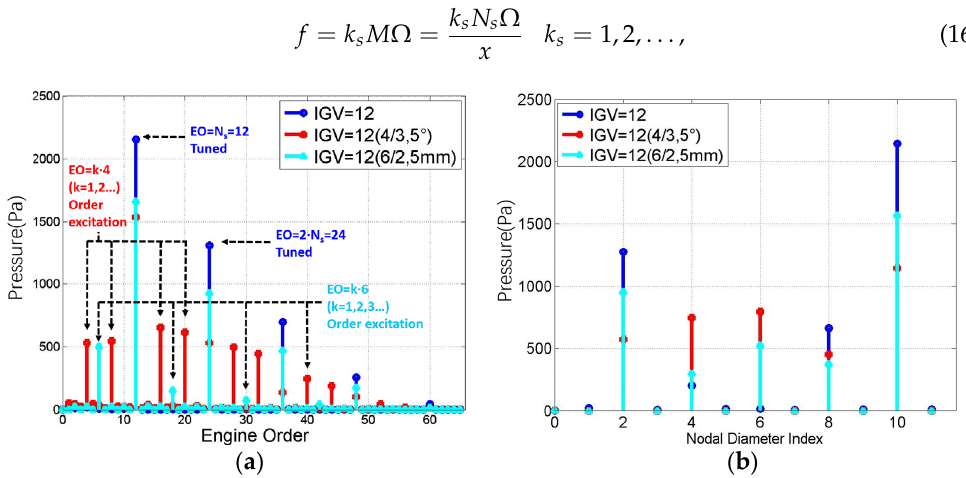
Figure 14. Frequency spectrum and circumferential wave spectrum comparison of the tuned and two other types of sectional non-uniform mistuned stators: ( a ) frequency spectrum and ( b ) circumferential wave spectrum.